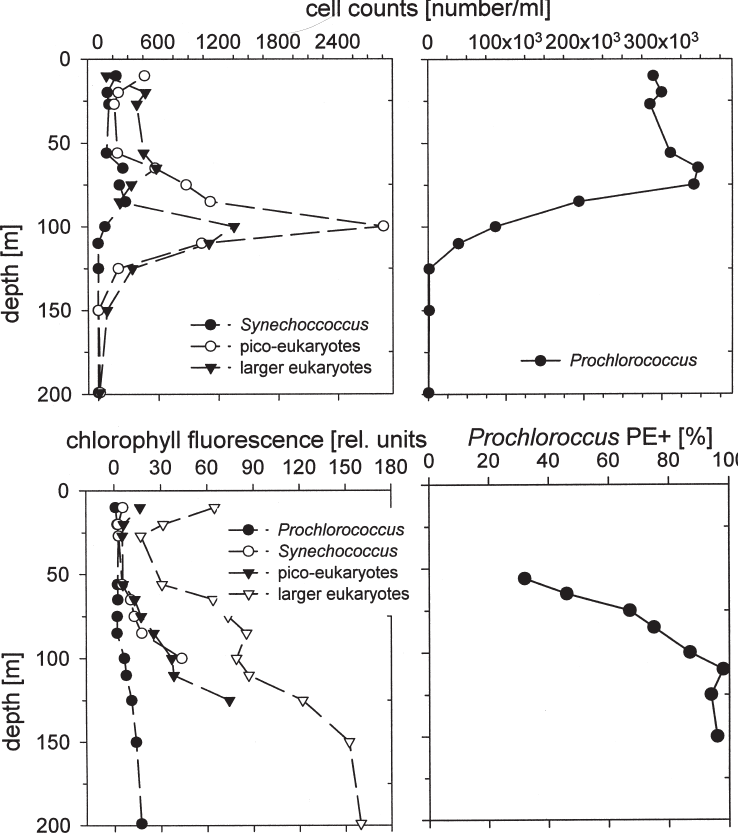
FLOW CYTOMETRY ANALYSIS OF PHYTOPLANKTON